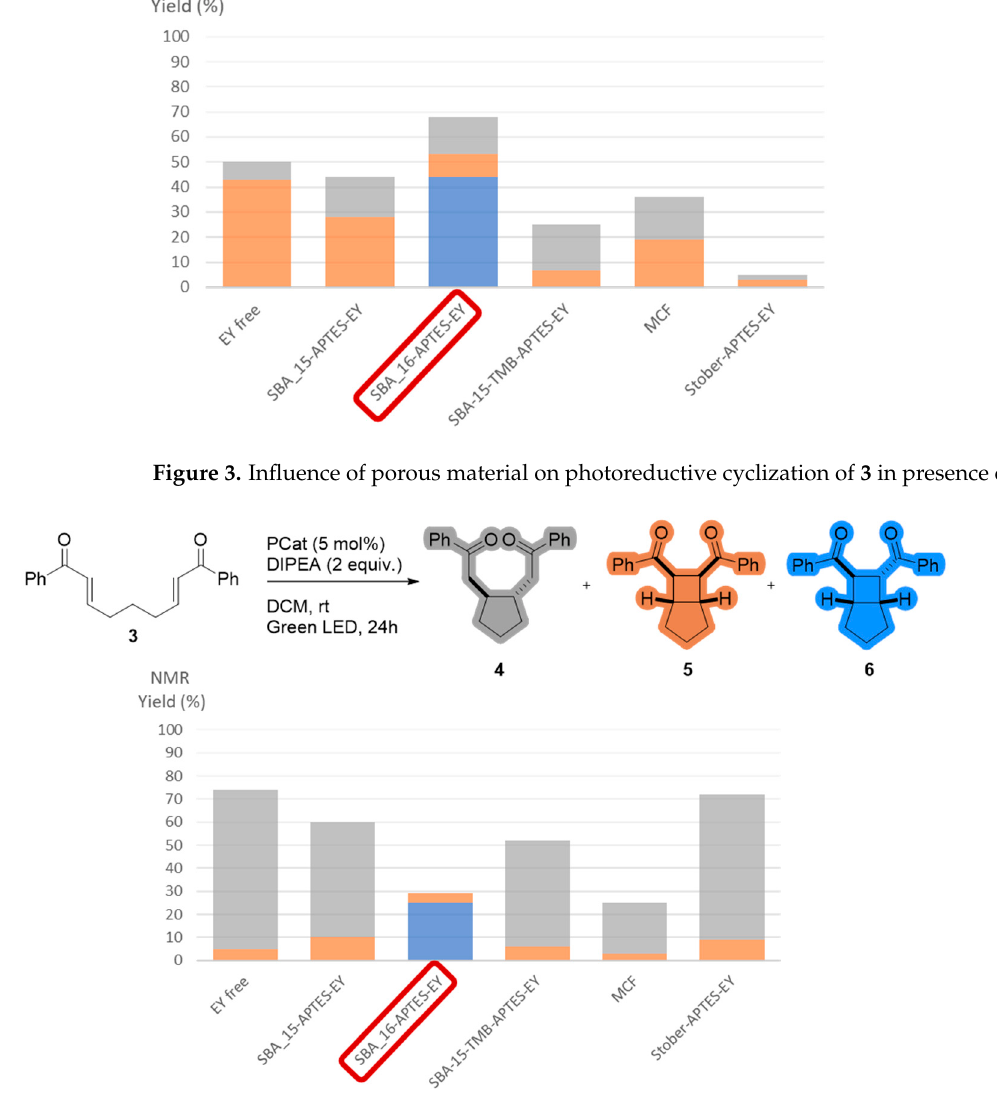
Figure 4. Influence of porous material on photoreductive cyclization of 3 in absence of LiBr.